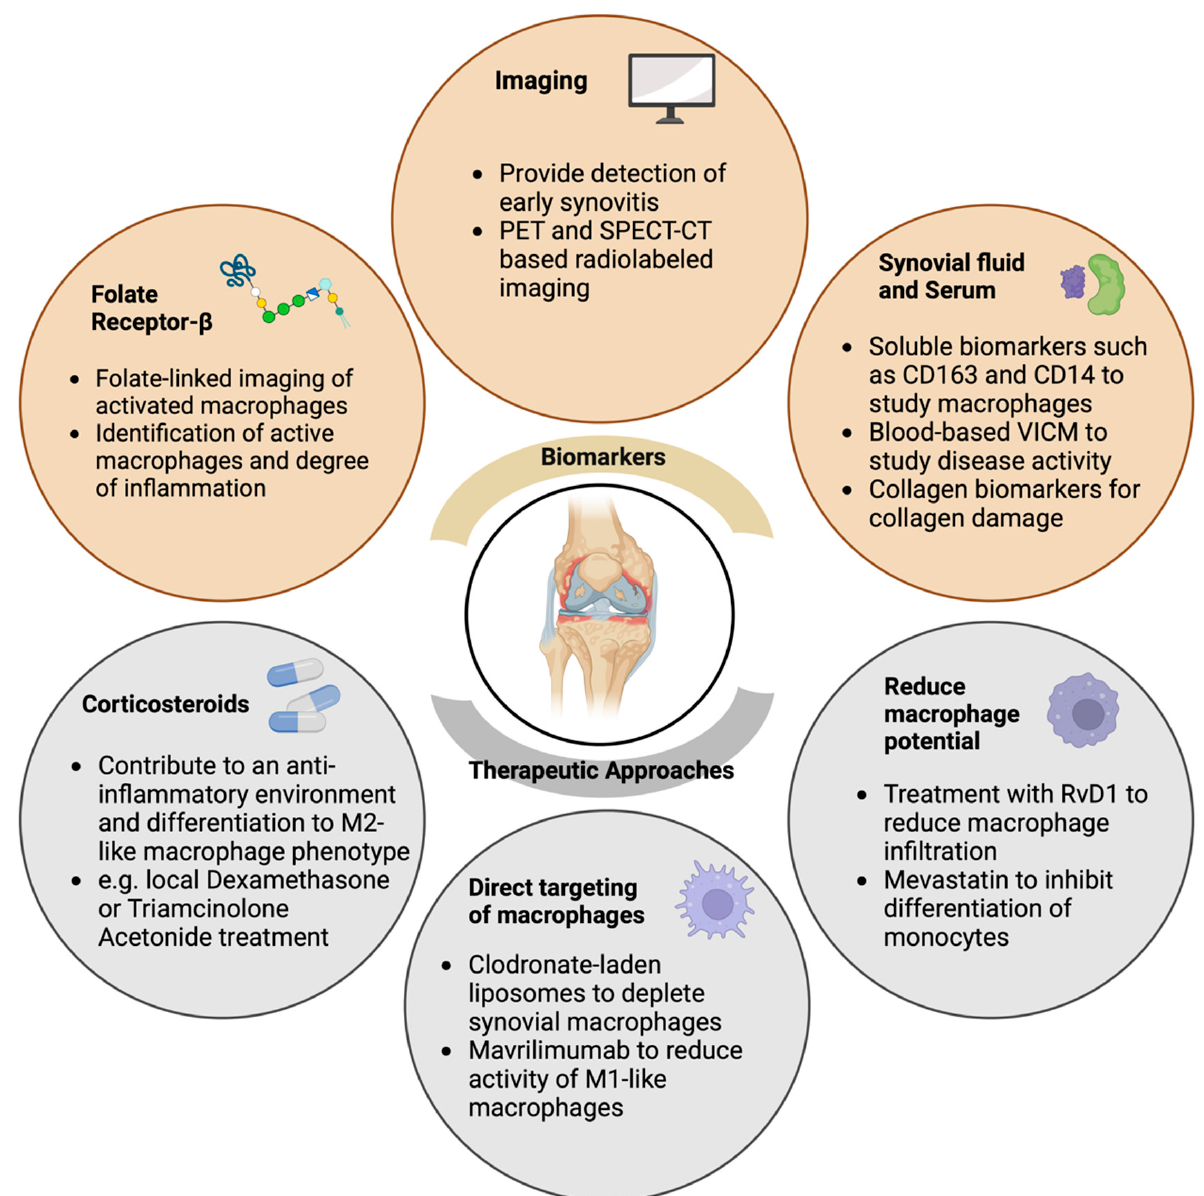
Figure 2. Possible candidates for macrophage-related biomarkers and therapeutic strategies in OA. Schematic representation summarizing the application of possible biomarkers and imaging candidates as well as therapeutic approaches to diagnose and treat inflammation-driven OA. PET: Positron emission tomography, SPECT: Single Photon Emission Computed Tomography, CT: Computed Tomography, IHC: Immunohistochemistry, IF: Immunofluorescence, VICM: marker of citrullinated and MMP-degraded vimentin, RvD1: resolvin D1. Created with BioRender.com, accessed on 9 March